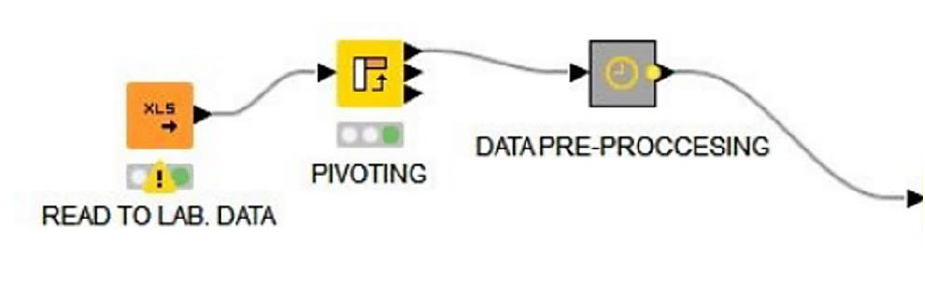
Figure 1. Data Pre-Processing.